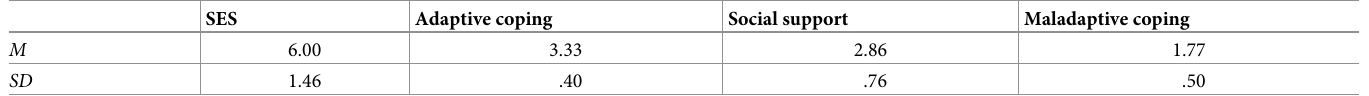
Table 5. Study 5 participants’ means and standard deviations on the measure of SES, empathy, and coping strategies. SES Adaptive